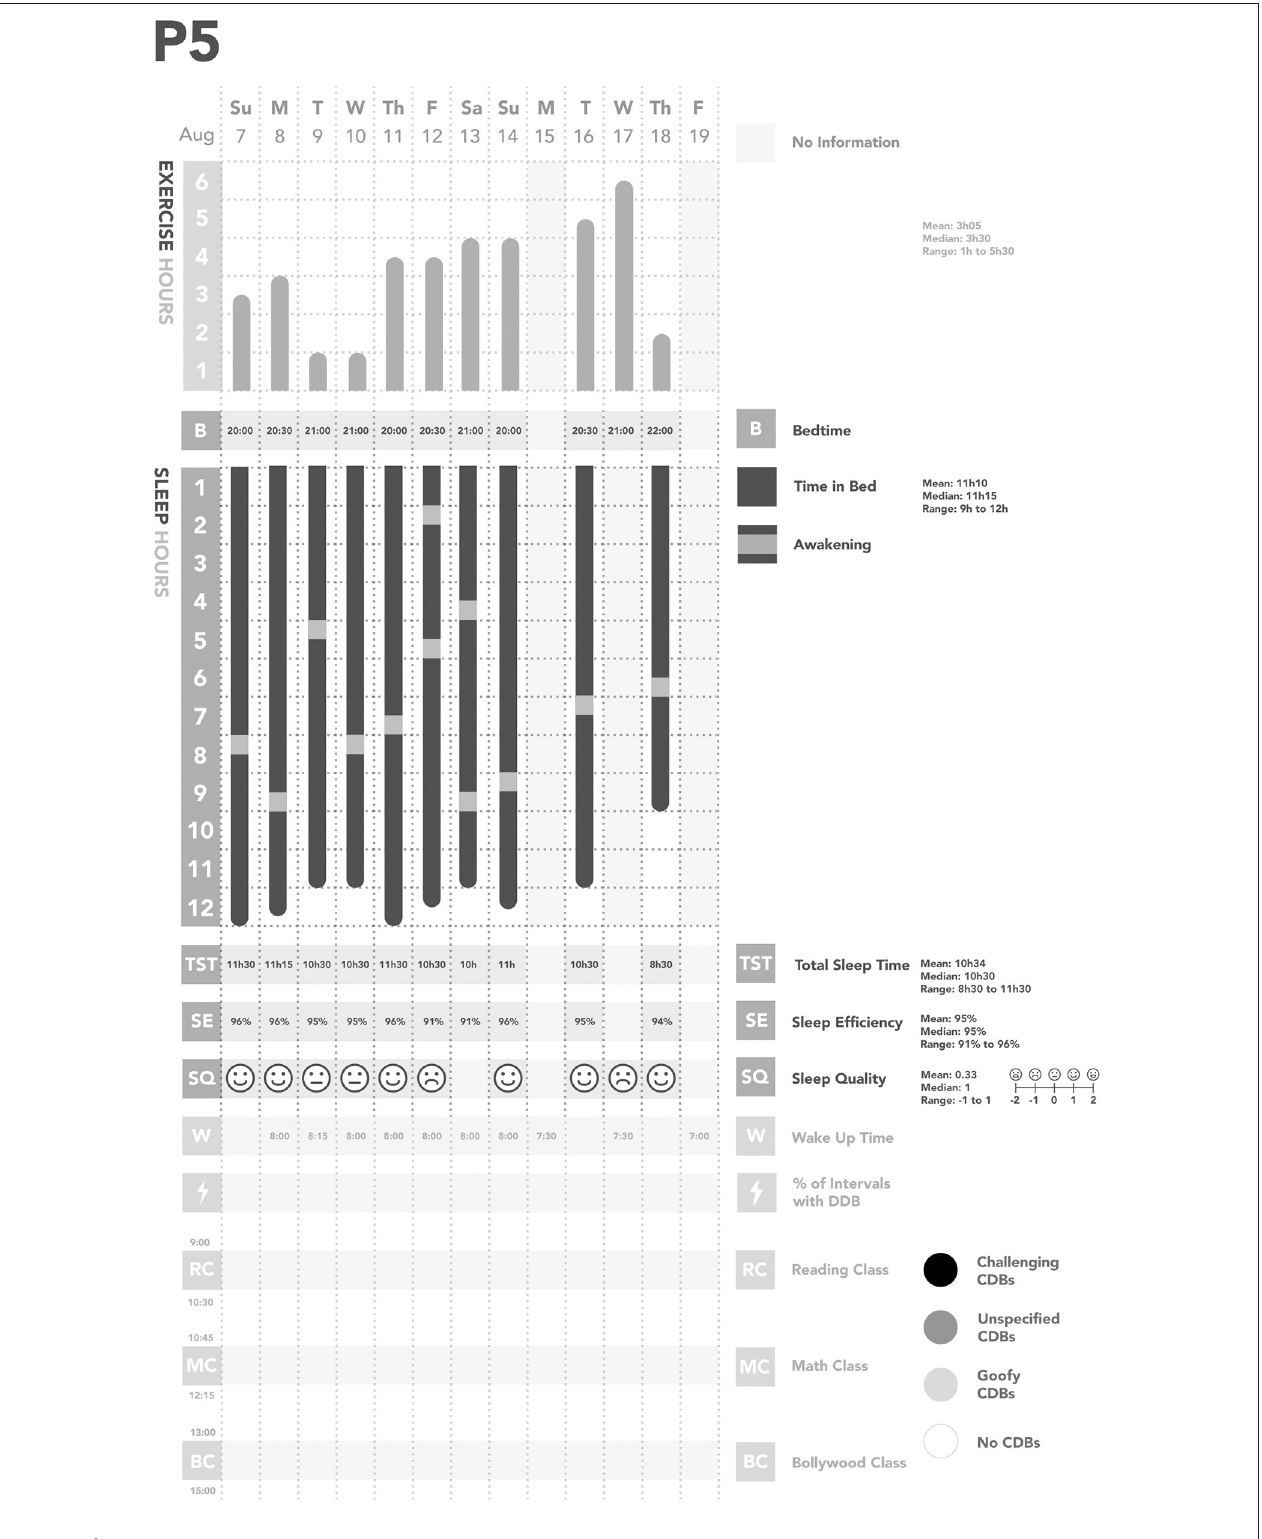
Frontiers in Psychiatry |